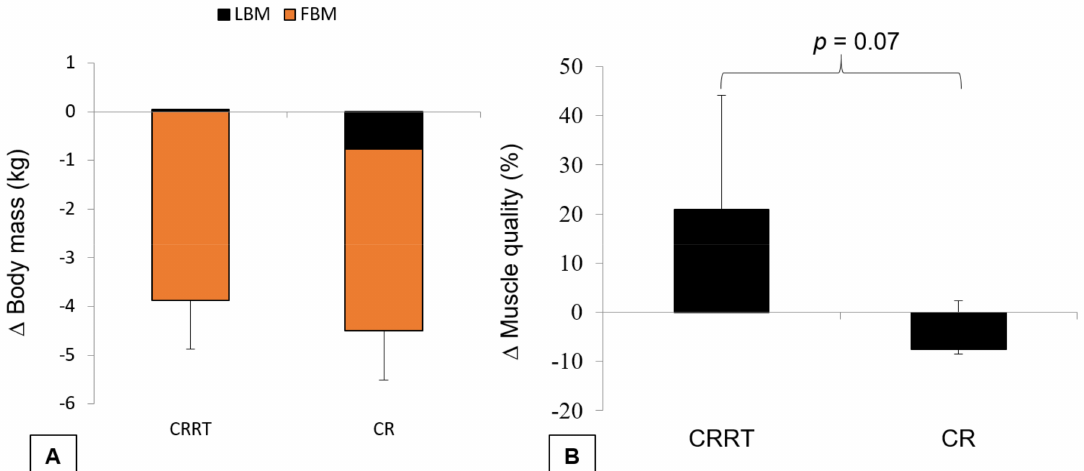
Figure 3. ( A ) Illustrative change in body mass after CRRT and CR; ( B ) percentage of muscle quality change after CRRT and CR. Data is presented in mean and standard deviation. P: p -value for difference between groups (Mann Whitney